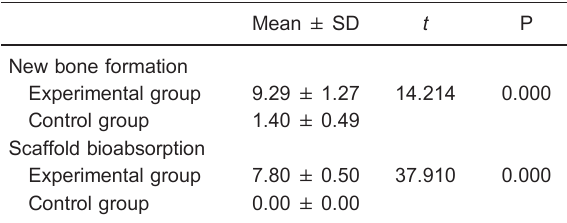
Table 1. Volume of new bone formation and of scaffold bioabsorption for the magnesium scaffold experimental group and hydroxyapatite scaffold control group (mm 3